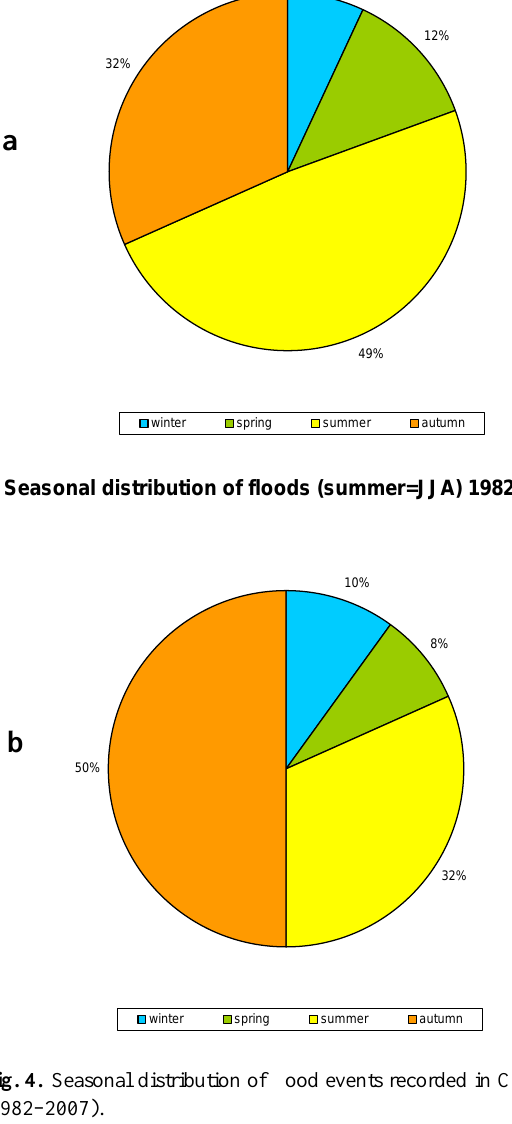
Table 1. Distribution of the number of flood events by category. Columns two and three show the number of each type of flood events that have swept away some cars (0,5) or that have produced casualties (5).